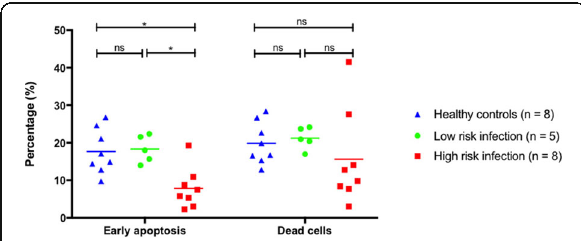
Fig. 4 (abstract P49). Number of apoptotic and dead cells as measured by Annexin V and Propidium Iodide (Pl) with flow cytometry analysis. Dead cells include the total of early apoptotic (Annexin V+ Pl-) and necrotic cells (Annexin V+ Pl+). p